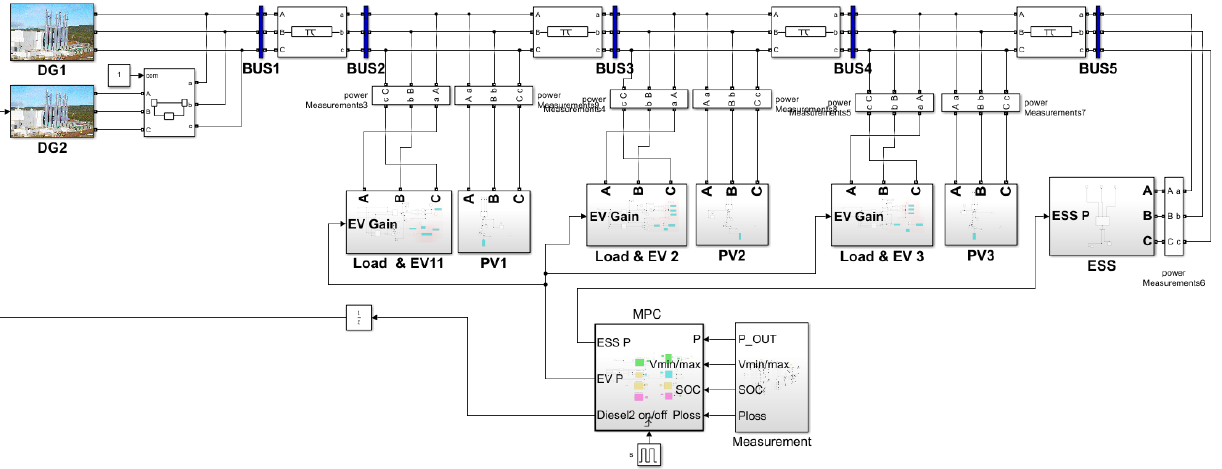
Figure 4. Simulation model of a stand-alone MG.